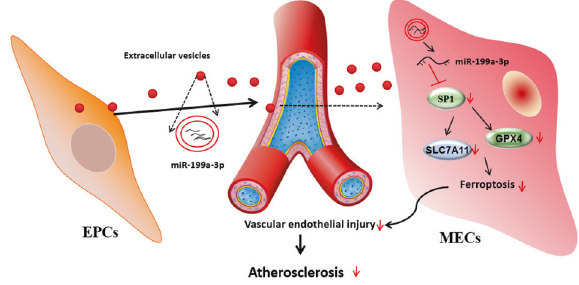
Fig. 7 Mechanism diagram. EPCs secrete EVs to deliver miR-199a- 3p and inhibit SP1, thereby inhibiting endothelial cell ferroptosis, delaying vascular endothelial injury, and ultimately alleviating atherosclerosis.